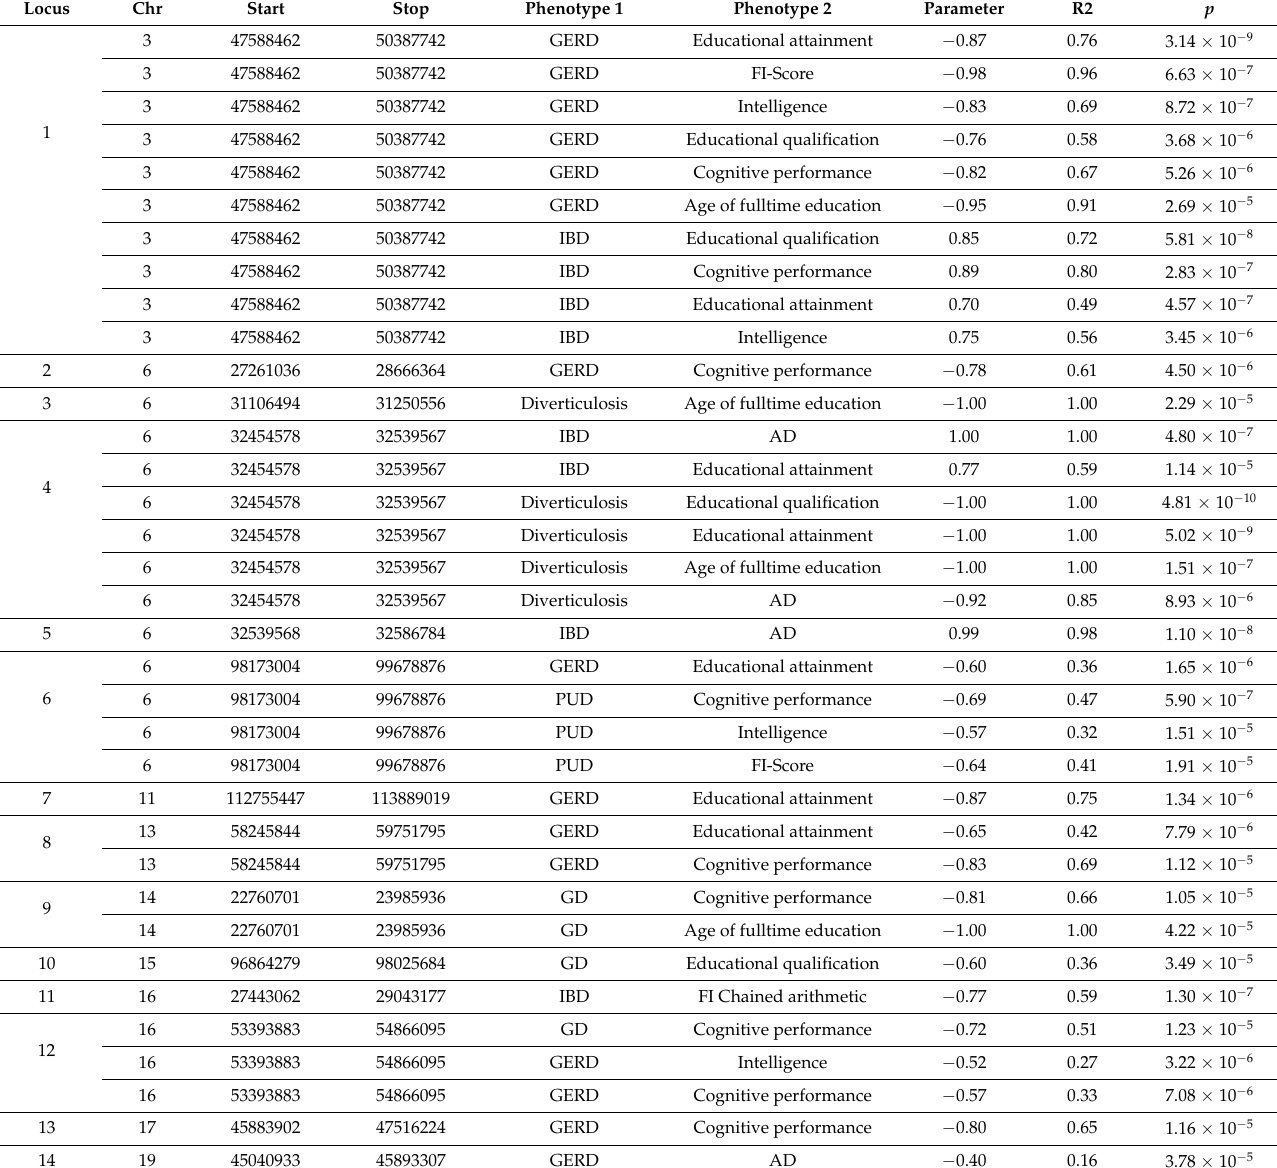
Table 2. LAVA local genetic correlations between GIT disorders, AD, and cognitive